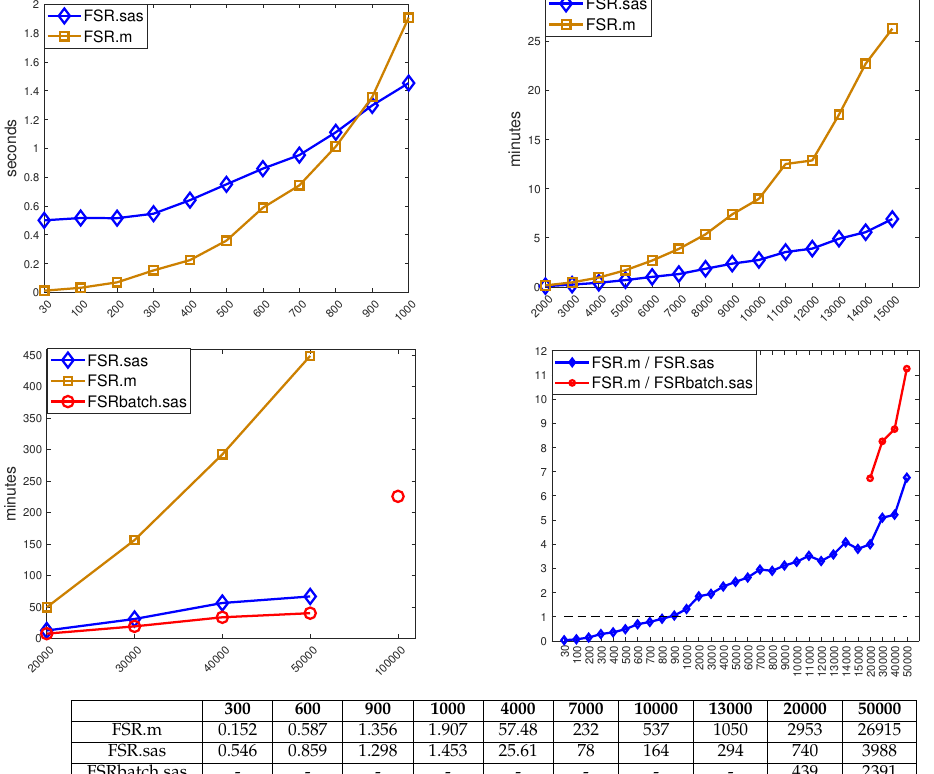
Figure 8. Execution time of our SAS (Version R9.4) and MATLAB (R2020a) implementations of the FSR function; for SAS, the comparison is also with the batch version of FSR (with k = 10). The assessment covers data with one explanatory variable and size ranging from 30 to 100,000. Results are split into three panels for small, medium and large data sizes. The last, bottom-right, panel gives the ratio between the time required by the MATLAB implementation and the two SAS ones. The associated table reports the time in seconds for selected sample